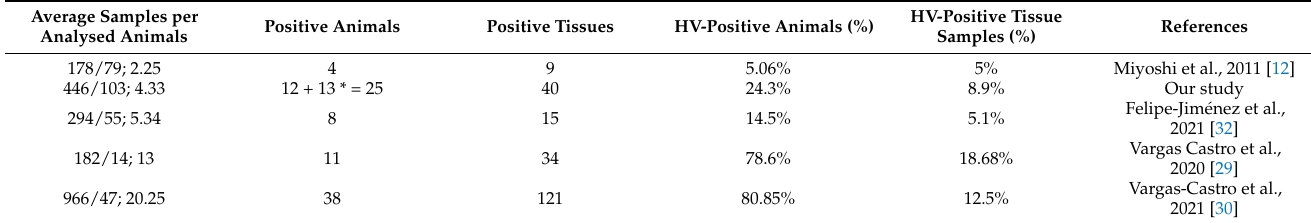
Table 4. Representative comparative scheme between different HV-infection frequencies related to the number of tissue samples and animals analysed. 13 *: this is the number of additional HV-positive animals not included in the present analysis of herpesviral encephalitis in